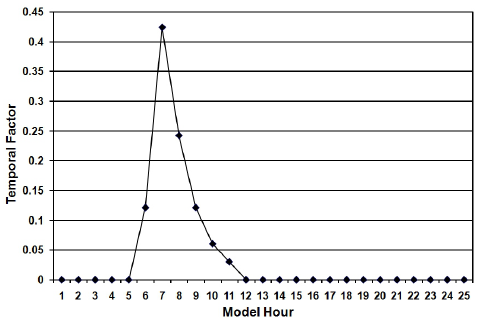
Fig. A6. Hourly temporal profile derived from the diel variability of HCl provided in Keene et al. (2007). This was applied to perform hourly allocations for the representative day of emissions created for oceanic HCl.